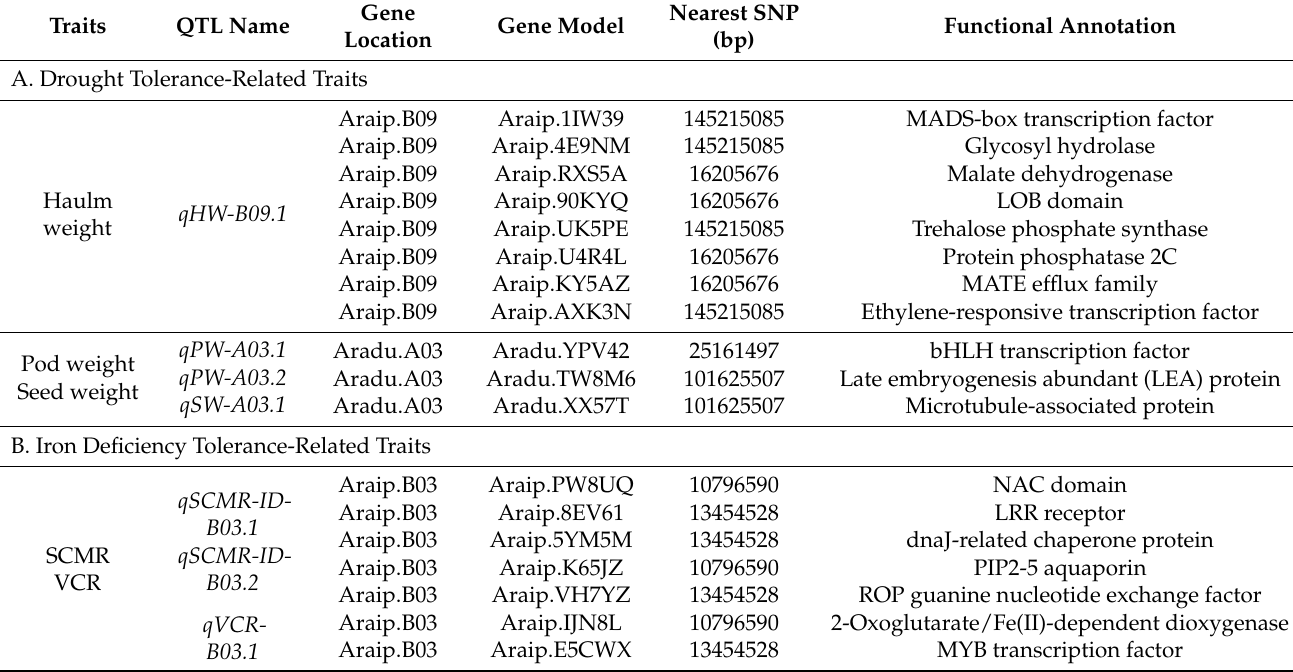
Table 6. Candidate genes underlying QTLs for drought tolerance- and ID tolerance-related traits.